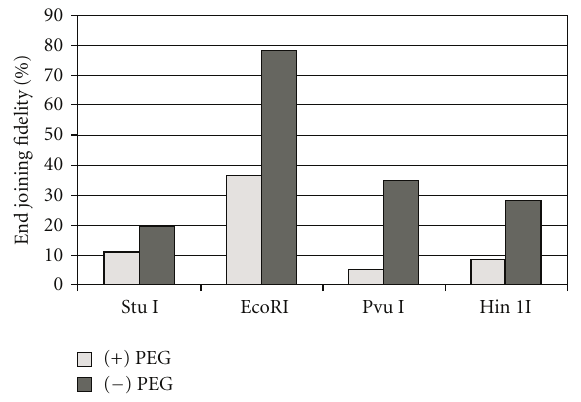
Figure 5: DNA end-joining fidelity reactions run in the presence or absence of 5% PEG. DNA DSB end joining was performed with each of the four di ff erent restriction enzyme linearized plasmid DNA substrates indicated to assess the e ff ects of di ff erent DSB overhang configurations (see text) upon the fidelity of DSB repair occurring under DNA-PK-independent and -dependent reaction conditions. DSB repair fidelity is measured as the fraction of total DNA end- joining reaction products that are capable of being recut with the restriction enzyme that was originally used to linearize the end- joining substrate DNA. All reactions were run in triplicate. Bars represent the average restriction enzyme redigestion e ffi ciency of the end-joining reaction products, which is reported as %